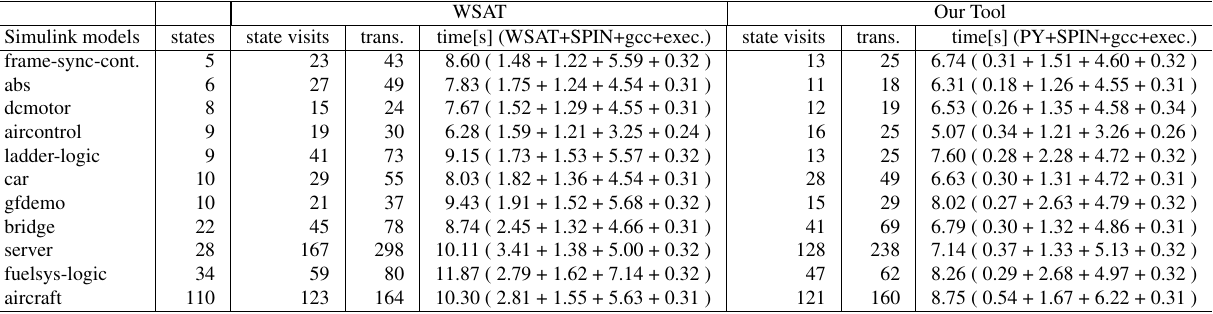
Table 2: Experimental results for checking liveness (deterministic) WSAT Our Tool Simulink models